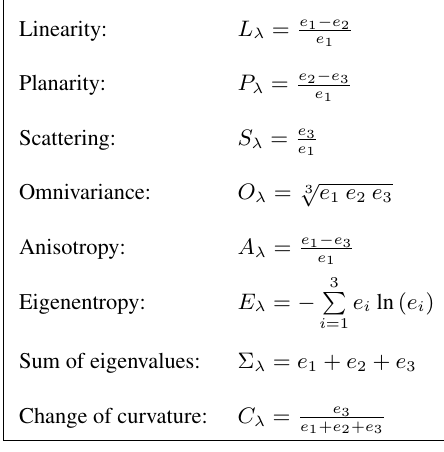
Table 1: Eigenvalue-based 3D